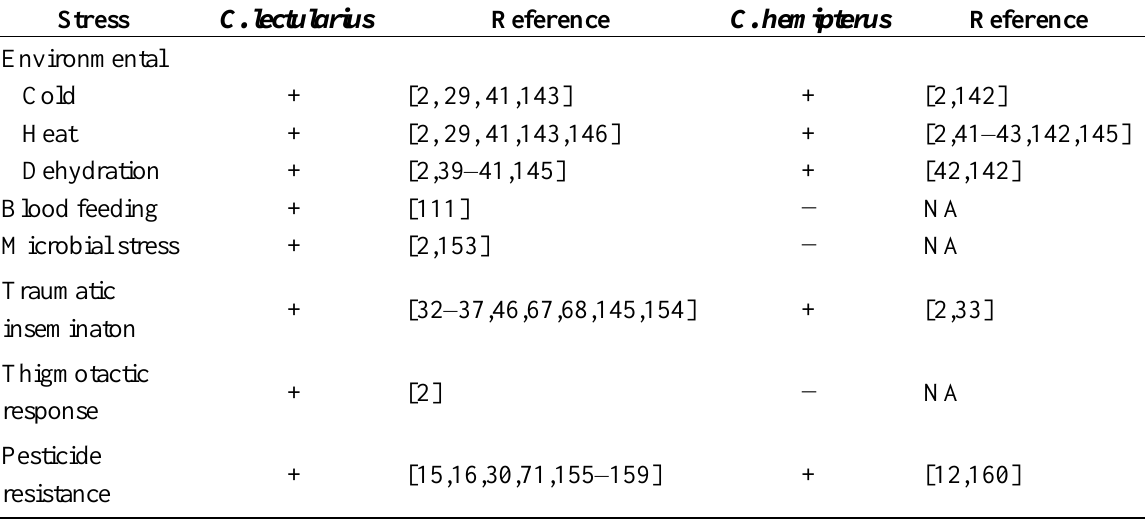
Table 2. Common stresses that bed bugs ( Cimex lectularius or C . hemipterus ) encounter throughout their lifetime. +: indicates this stress has been studied; −: indicates this stress has not be